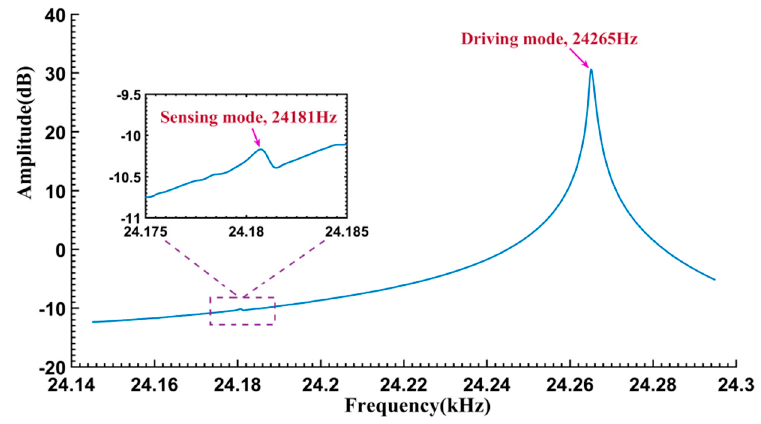
Figure 7. Amplitude-frequency response of the driving mode.